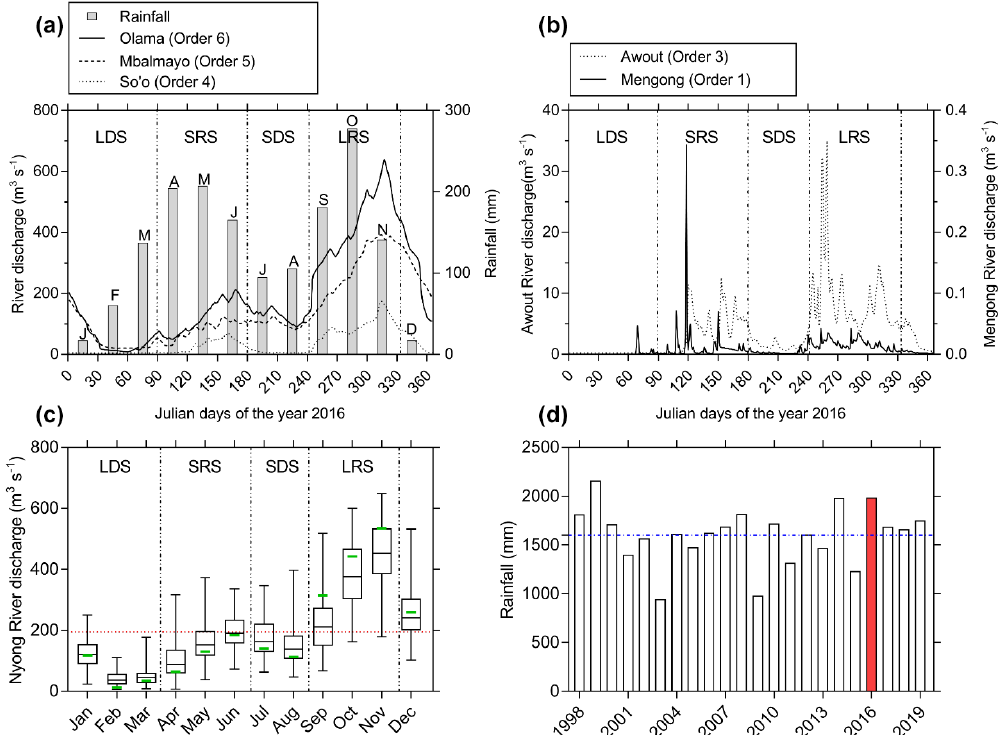
Figure 2. (a–b) River discharges of the different gauging stations during the sampling year 2016, associated with rainfall measured at the Mengong catchment. (c) The box plots represent the variability of monthly Nyong River discharges from 1998 to 2020, and extreme box plot values represent minimum and maximum monthly discharges during the same period. The green lines represent the average monthly discharges in 2016, and the red dashed line represents the yearly average discharge of 194.5m 3 s − 1 for the 1998 to 2020 period (very close to the yearly average discharge of 195m 3 s − 1 measured in 2016). (d) Yearly rainfall in the Nyong watershed (measured in the Mengong catchment): the blue line represents the mean rainfall over the 1998–2020 period (1600 ± 290mm), and the red bar represents the yearly rainfall during the sampling year 2016. Hydrologic and rainfall data are from Audry et al.